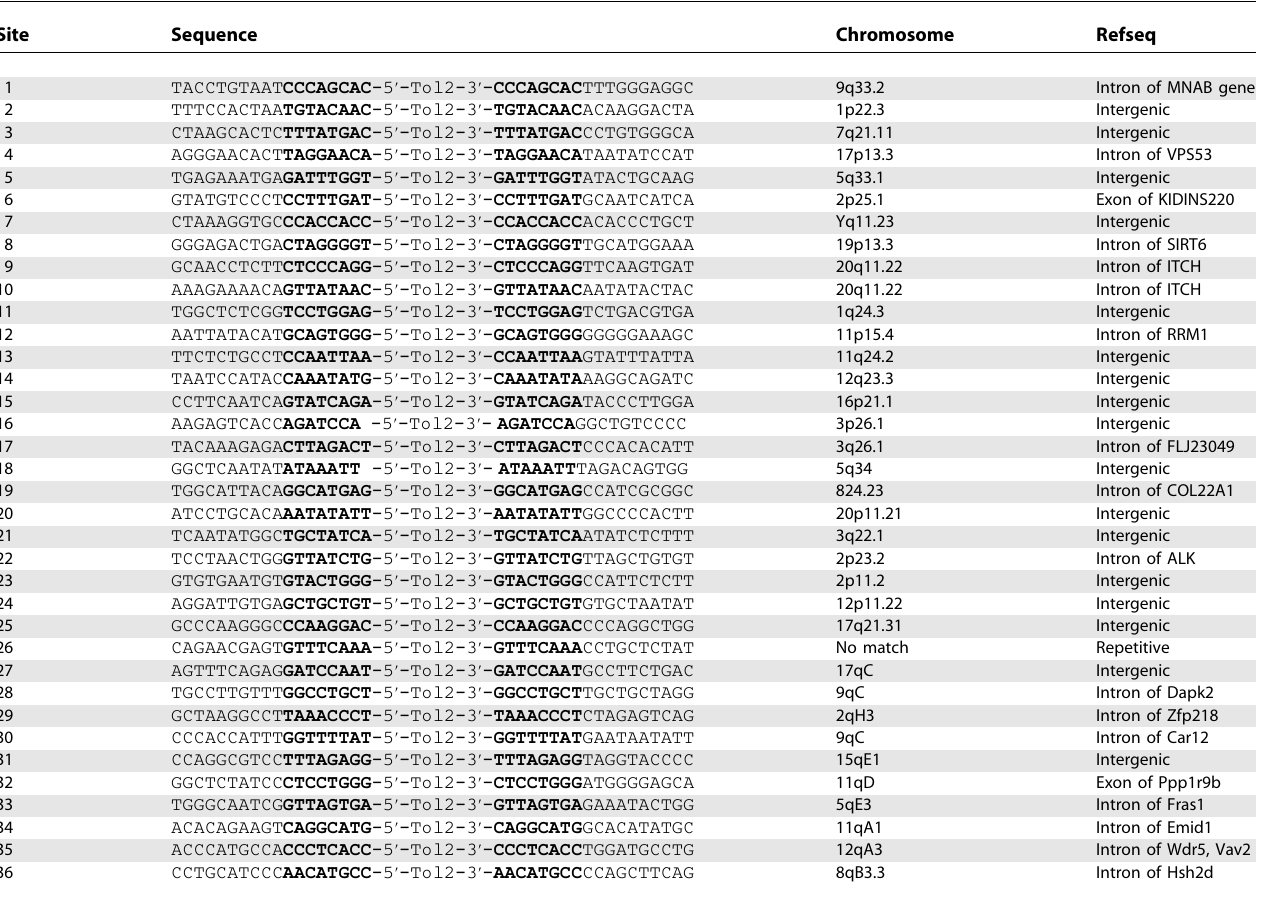
Large Cargo-Capacity Vertebrate